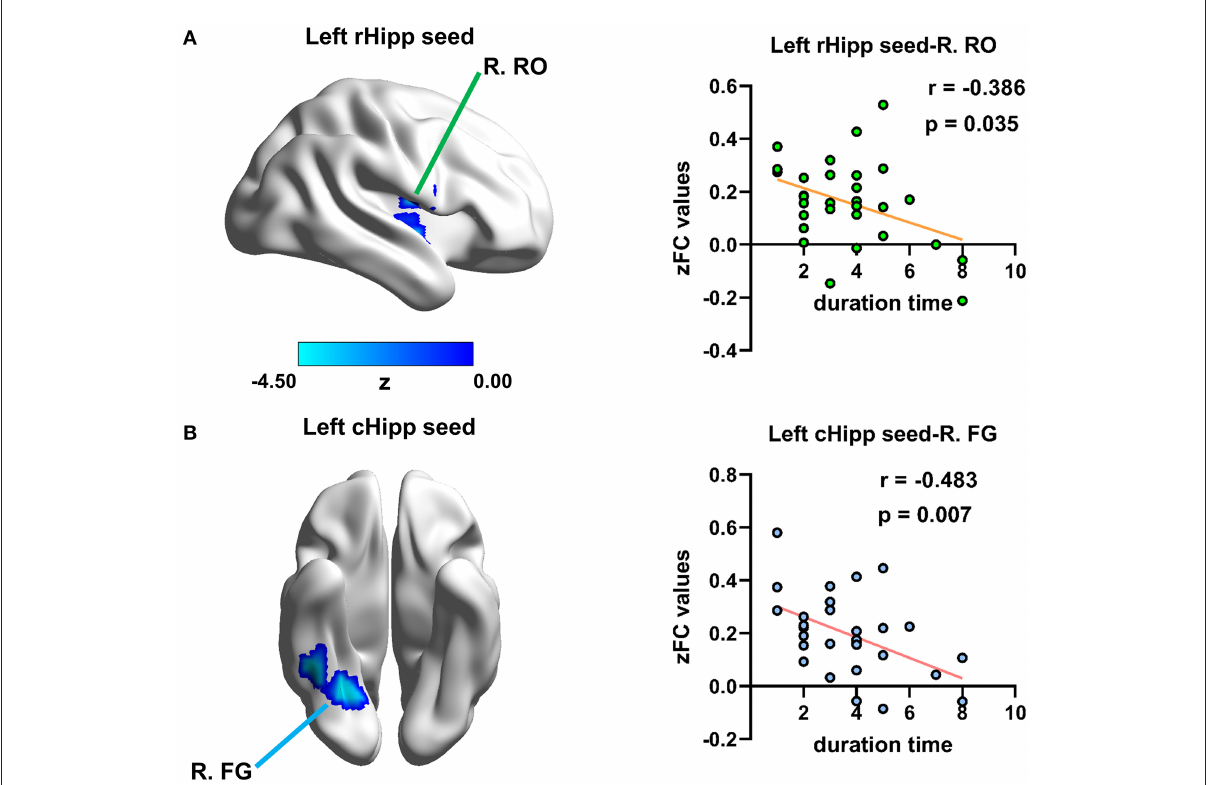
FIGURE5 Relationship between disease duration time and altered RSFC values in children with PNE. Disease duration time was negatively correlated with RSFC of (A) the left rHipp with right Rolandic operculum and (B) the left cHipp with right fusiform gyrus in the PNE group, respectively. rHipp, rostral hippocampus; cHipp, caudal hippocampus; PNE, primary nocturnal enuresis; R. RO, right Rolandic operculum; R. FG, right fusiform gyrus; color bar, z